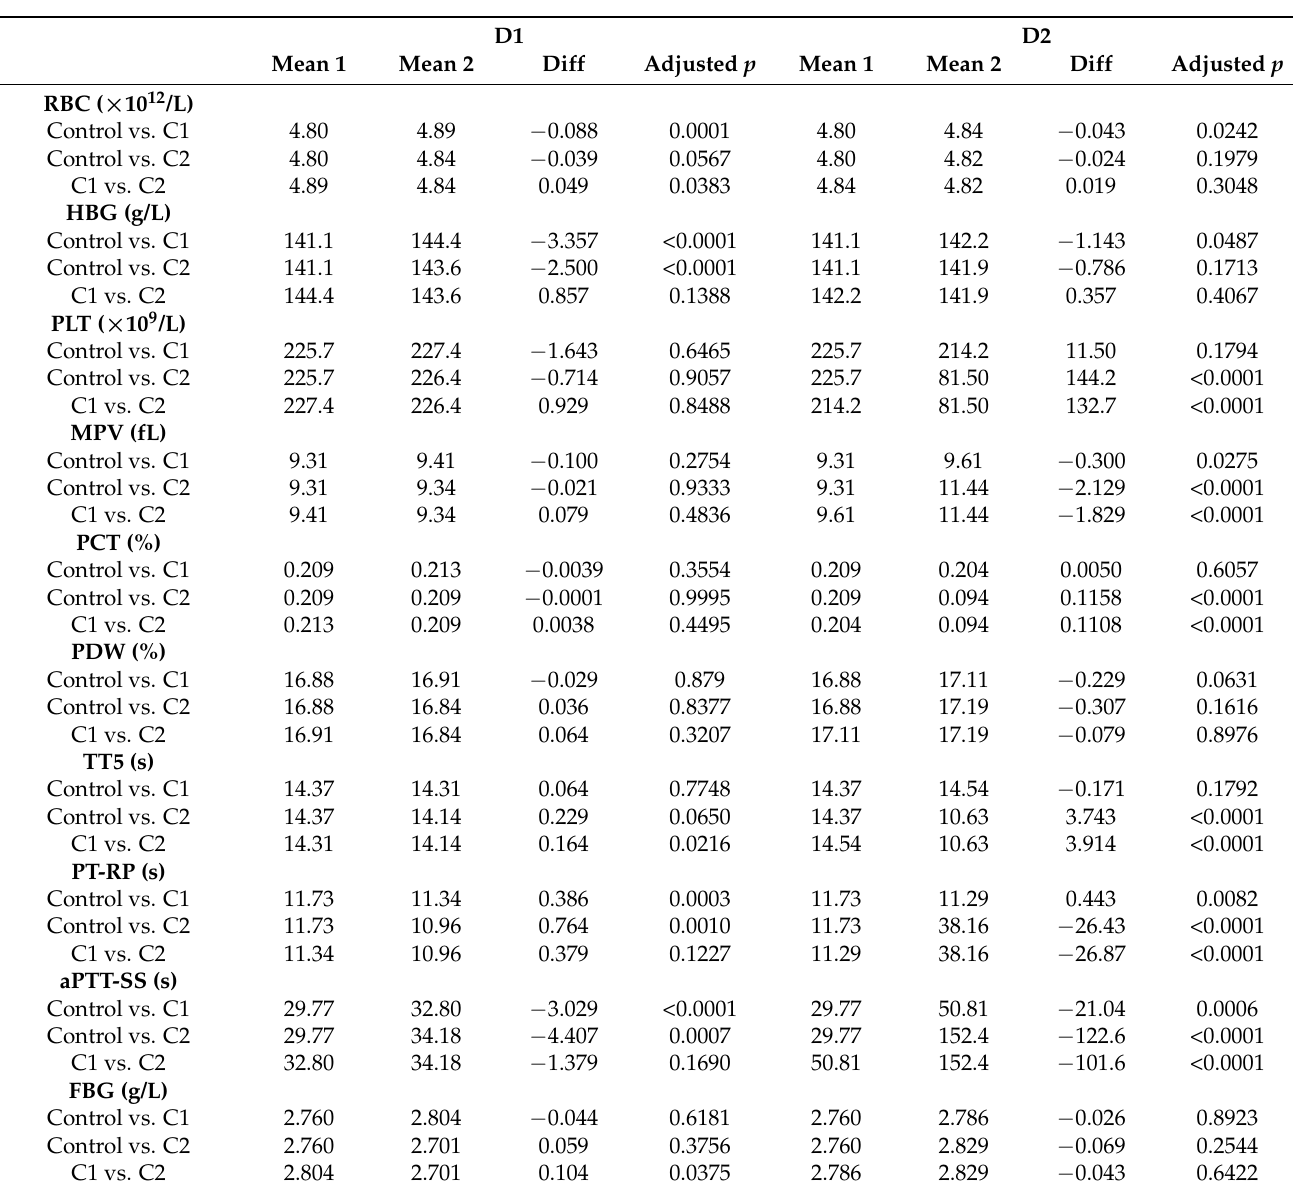
Table A1. Descriptive statistics and differences in the selected hematology and coagulation parameters across experimen- tal